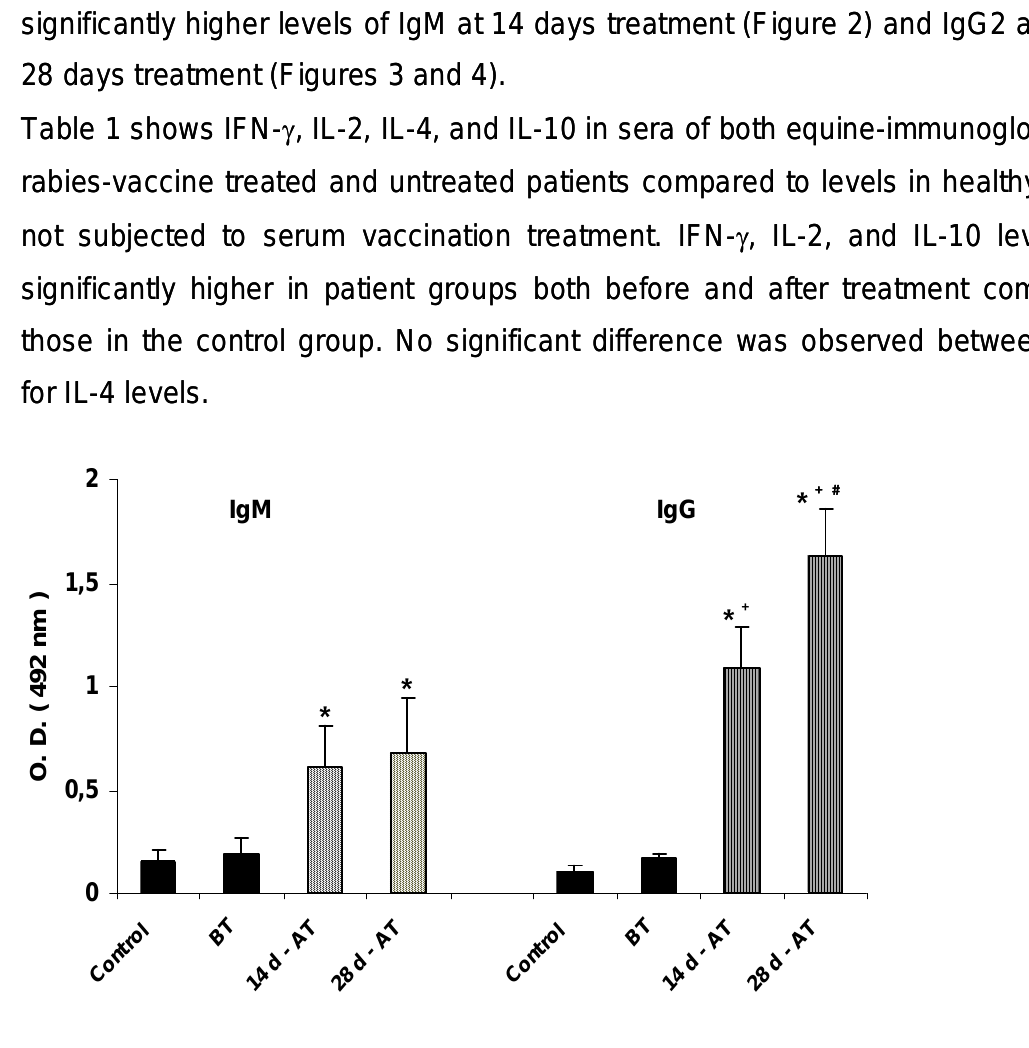
Figure 1: Anti-equine IgM and IgG immunoglobulin antibodies in sera of patients evaluated before (BT) and after (AT) treatment with rabies serum vaccination. Results are expressed as mean + SD of optical density (OD) * ( p <0.05) versus control, BT; + ( p <0.05) versus IgM; # ( p <0.05) versus 14d-AT